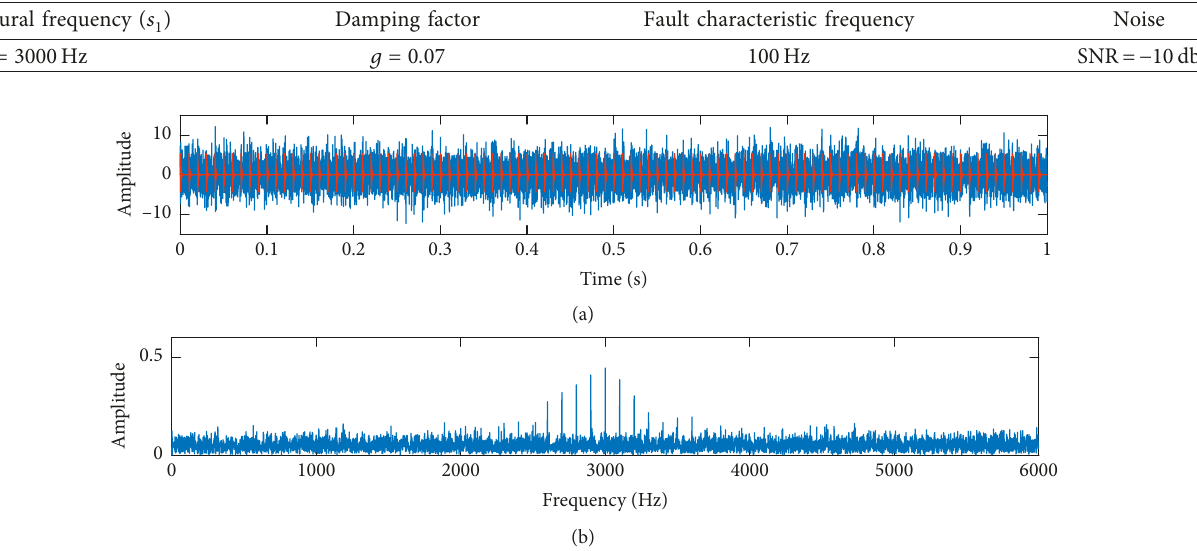
Figure 6: (a) Red: the impulsive signal; blue: the simulated signal mixed with impulsive signal and white Gaussian noise with SNR (b) the spectrum of the simulated